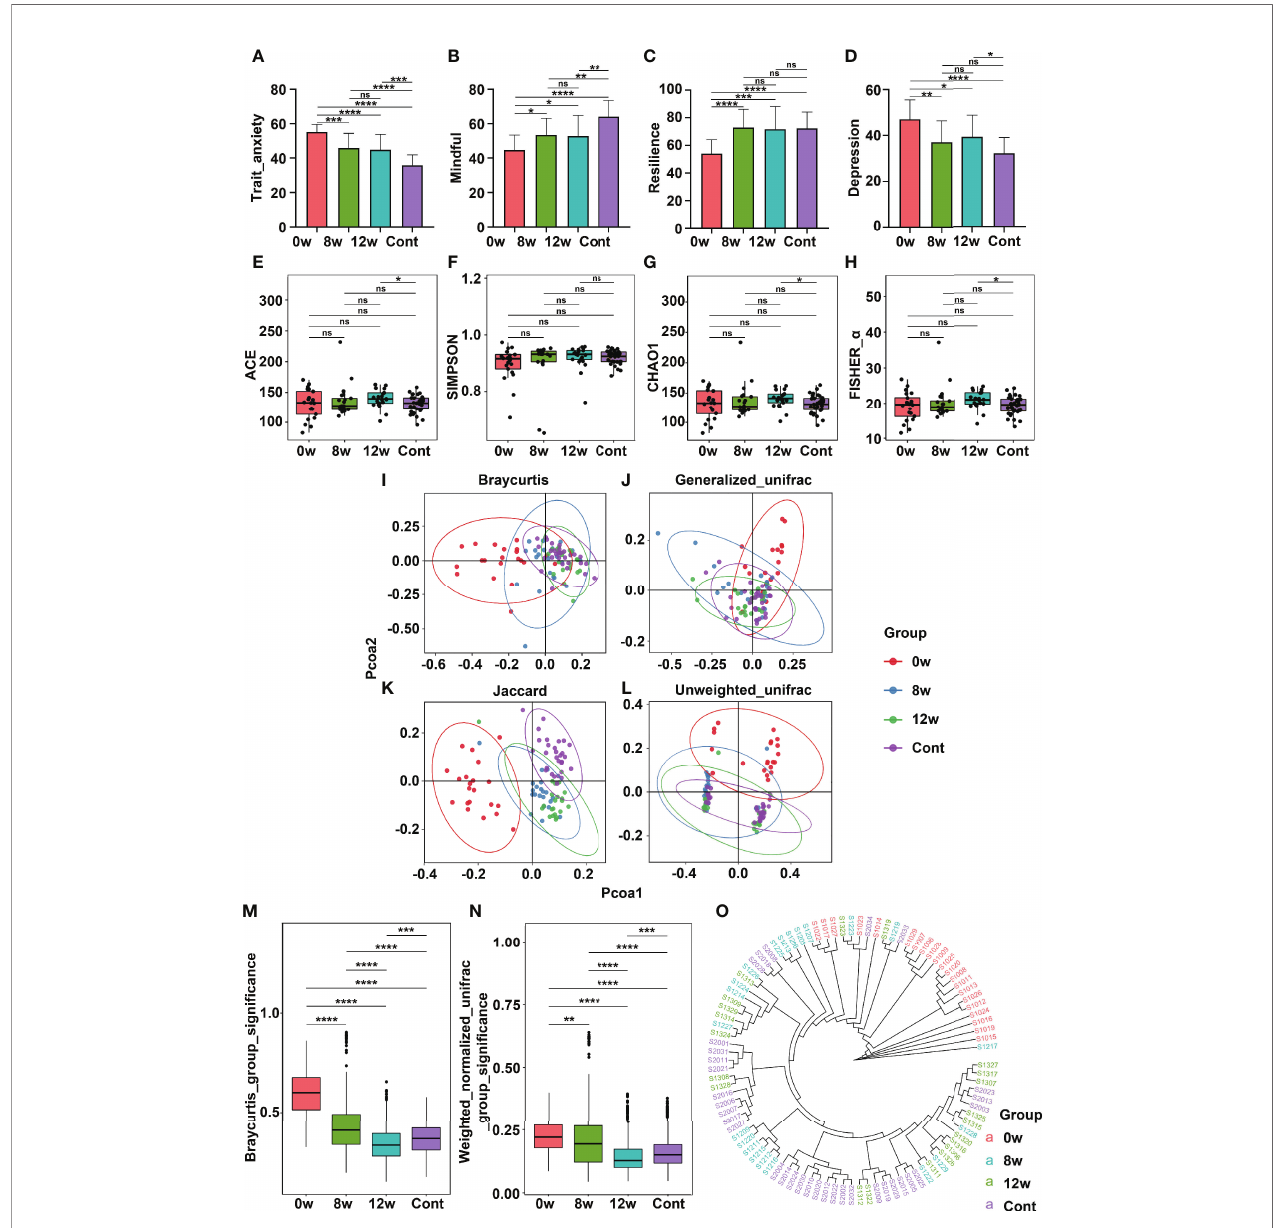
FIGURE 2 | Comparison of psychometric indicators, diversity indices, and PCoA in different time points before and after MBCT intervention (at baseline, at the end of intervention, and at 4 weeks following the end of intervention). The scores were compared on scales of STAI (A) , MAAS (B) , CD-RISC (C) , and SDS (D) . The a - diversity indices included Ace Index (E) , Simpson_E Index (F) , Chao1 (G) , and Fisher_ a (H) . The b -diversity indices were illustrated according to PCoA analysis by different algorithms (I – L) . Clustering of fecal bacterial communities: the distance indices (M, N) and cluster tree (O) . * means p value <0.05; **means p value <0.01; *** means p value <0.001; **** means p value <0.0001; ns means not signi fi